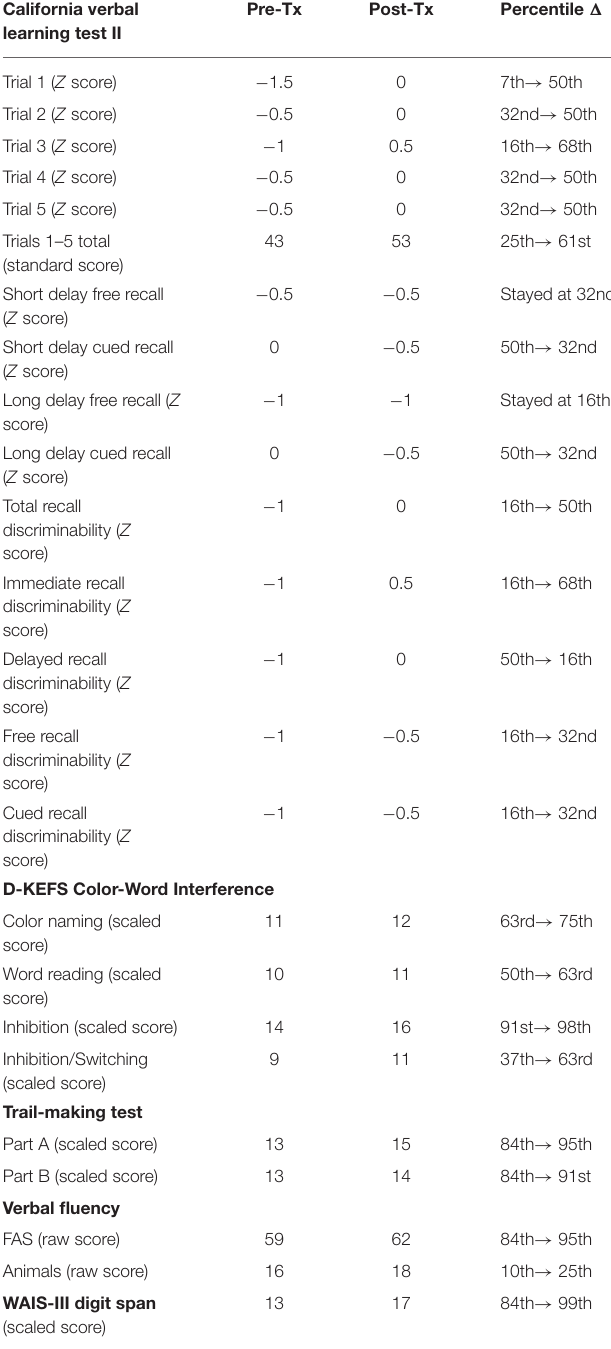
TABLE 2 | Summary of the subject’s pre- and post-treatment (Tx) neuropsychological test